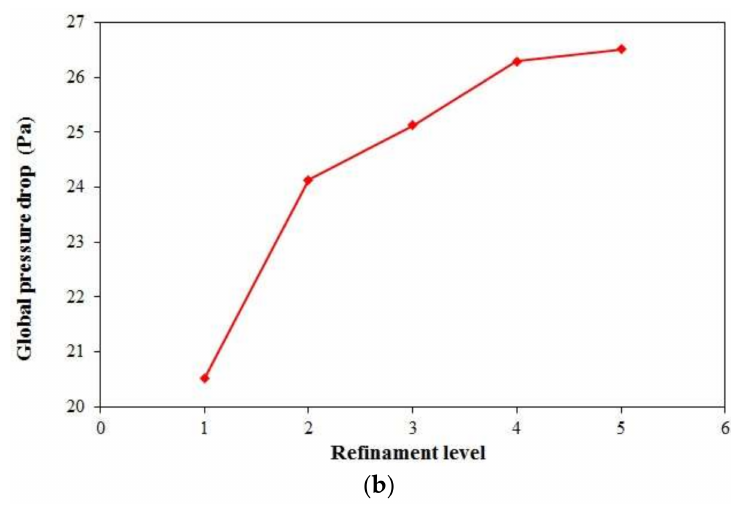
Figure 5. Grid sensitivity analysis for ( a ) flow distribution in risers, and ( b ) global pressure drop.